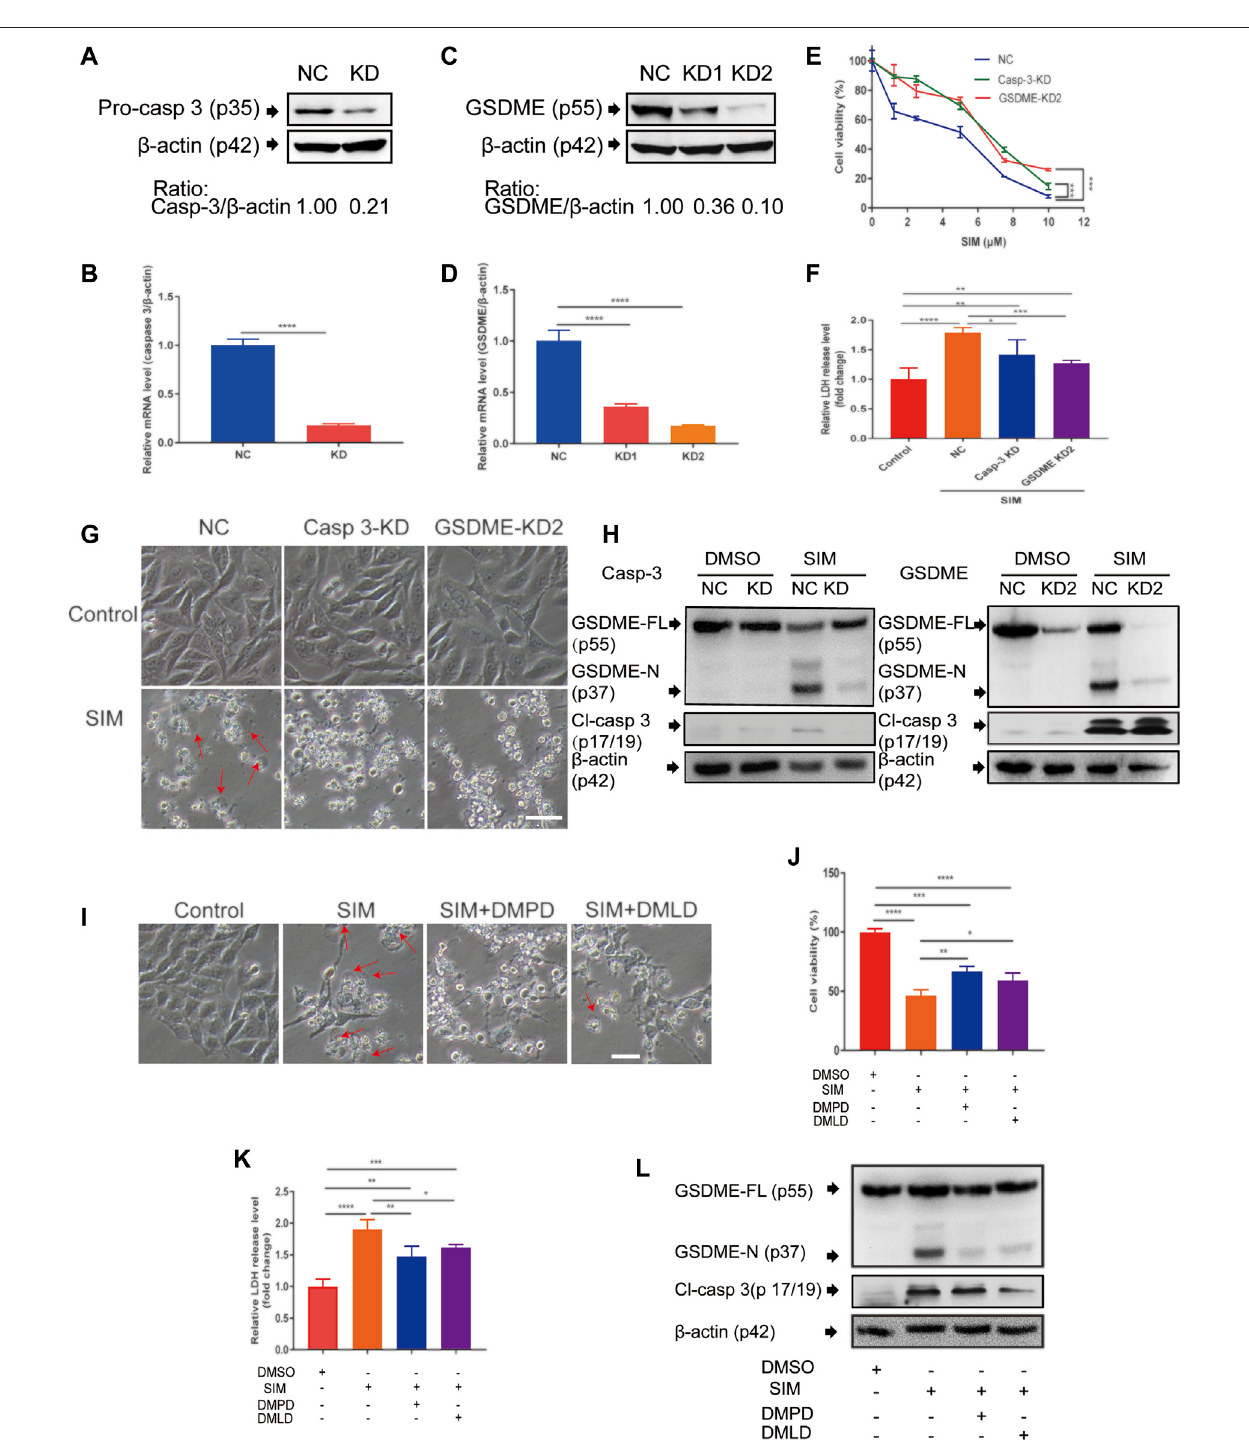
FIGURE2| Caspase-3andGSDMEarerequiredinSIM-inducedpyroptosis. (A – D) ValidationoftheshRNAknockdownofcaspase3orGSDMEinMGC-803cells by Western blotting and RT-qPCR. After the treatment of SIM at concentrations ranging from 0 to 10 μ M with caspase 3 or GSDME knockdown, scrambled NC as the control, (E) cellviabilitywasdetectedbyCCK8( n =3)and (F) releaseofLDHintotheculturesupernatantwasdetectedbyLDHassaykit( n =4), (G) Microscopicimaging of the cells treated with 5 μ M SIM for 48 h, w/wo caspase 3 or GSDME knockdown. Red arrows indicate ballooned cell membrane; scale bar = 50 μ m ( n = 3). (H) RepresentativeimmunoblottinganalysisofGSDME andcl-casp3ofthecellstreatedwith5 μ MSIMfor48 h,w/wo caspase 3orGSDMEknockdown. (I – L) Microscopic morphology, cell viability, LDH release and protein cleavage of GSDME and caspase-3 of MGC-803 cells treated with 5 μ M SIM for 48 h, w/wo the caspase-3 inhibitor Ac-DMPD-CMK (DMPD)or Ac-DMLD-CMKR (DMLD). Dataareshown asmean ±SD or representatives ofat least three independent experiments. β -actin wasused as an internal control for Western blot. p p < 0.05, pp p < 0.01, ppp p < 0.001 and pppp p < 0.0001.